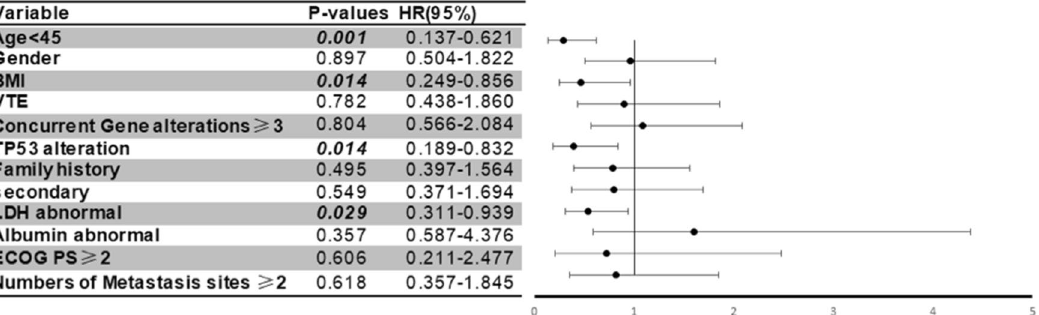
Figure 3. Forest plot of multivariate analysis of risk factors (age < 45 years old, BMI ≥ 25 kg/m 2 , TP53 mutation, and elevated LDH) for overall survival after initial metastasis diagnosis.